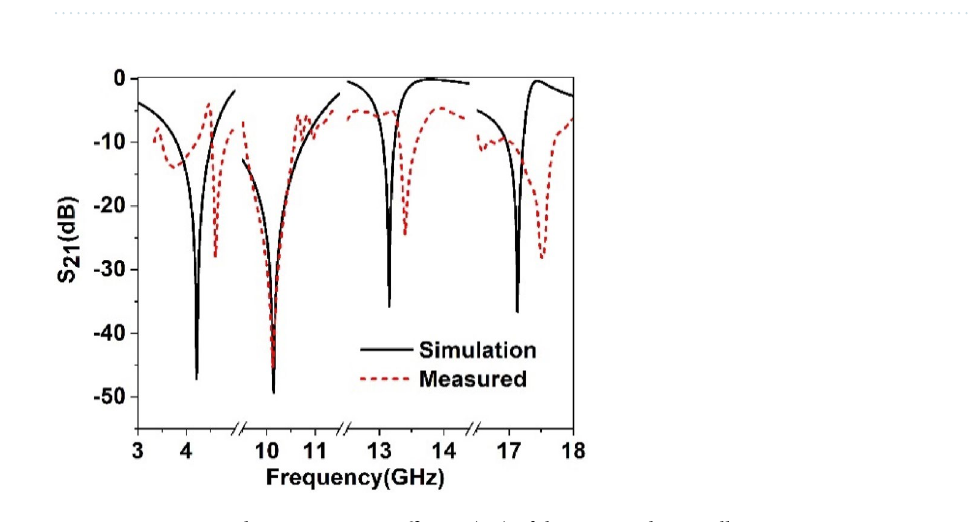
Figure 21. Measured transmission coefficient (S 21 ) of the proposed unit cell.